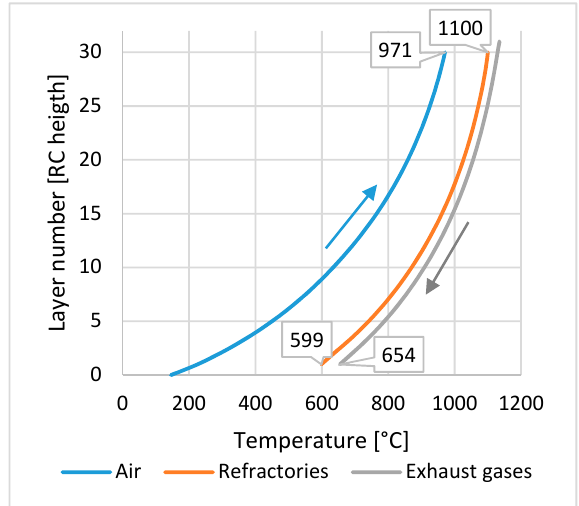
Figure 4. Average temperature profile across the regenerative chamber (RC) height (reference case).